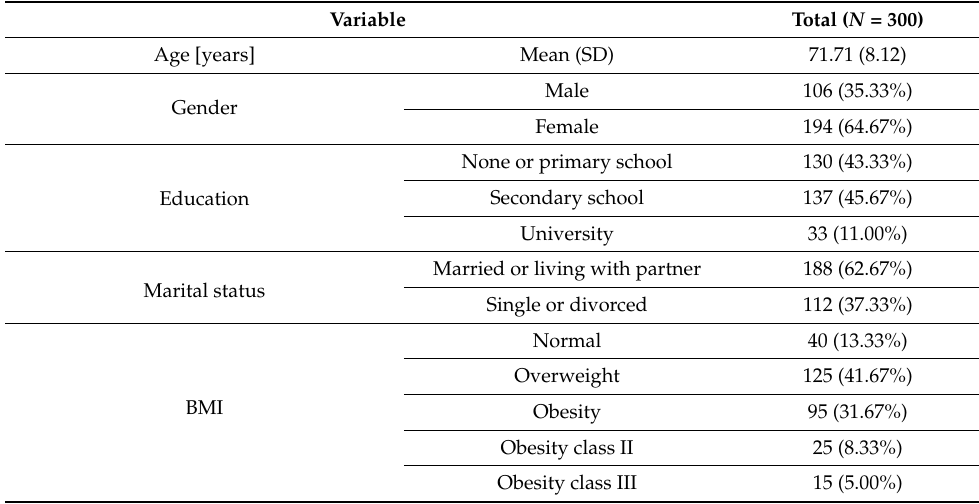
Table 1. Sociodemographic and clinical characteristics of patients according to